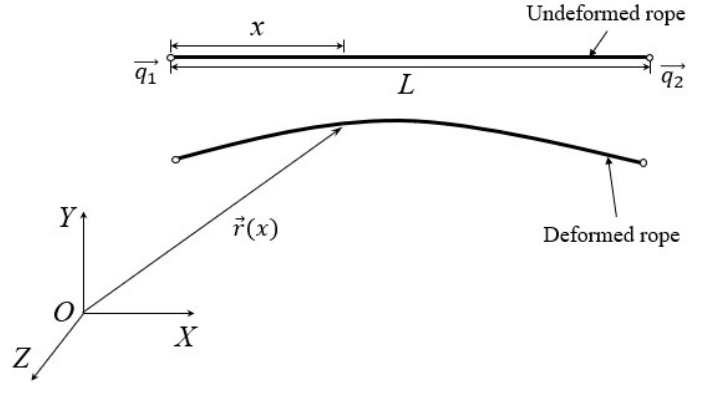
Figure 2. Model of ANCF rope